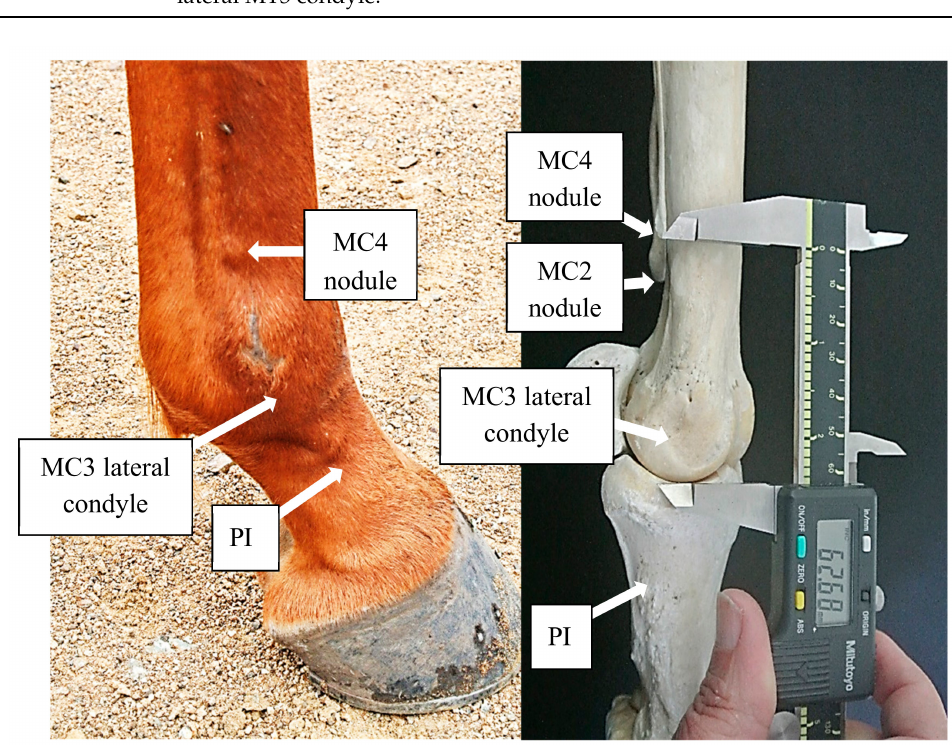
Figure 2. The distal nodule of MC4 is easily visible in the right forelimb of this 5-year-old Thoroughbred (left). The photo on the right demonstrates the technique used for measuring the nodule to condyle distance, in this case of MC4